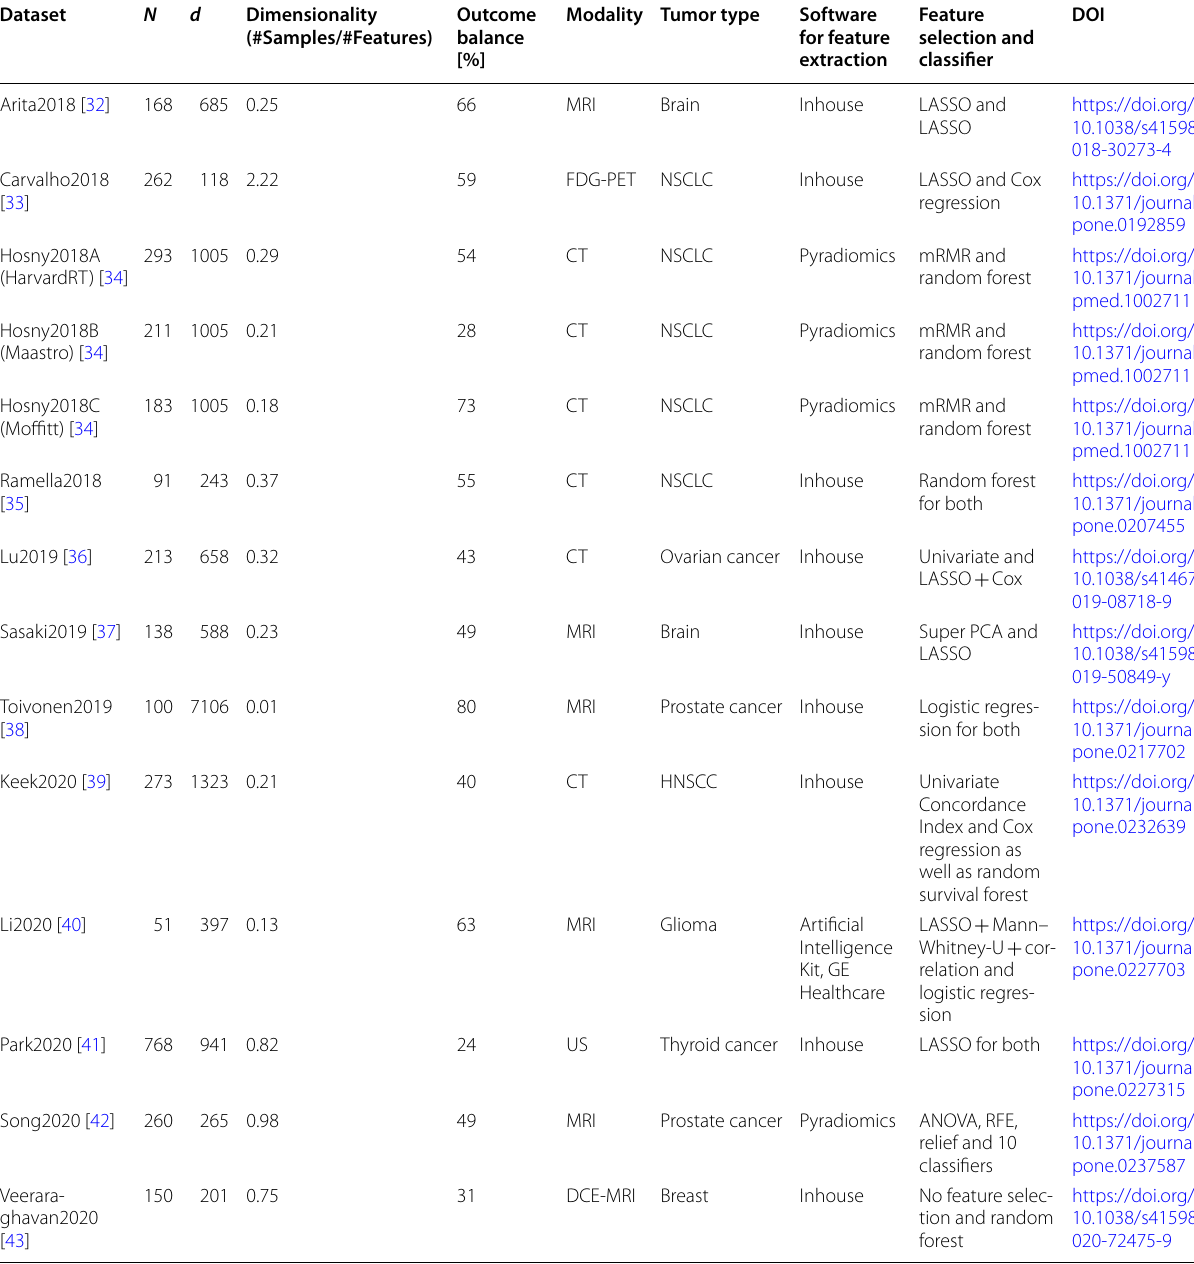
Table 1 Overview of the datasets used for the